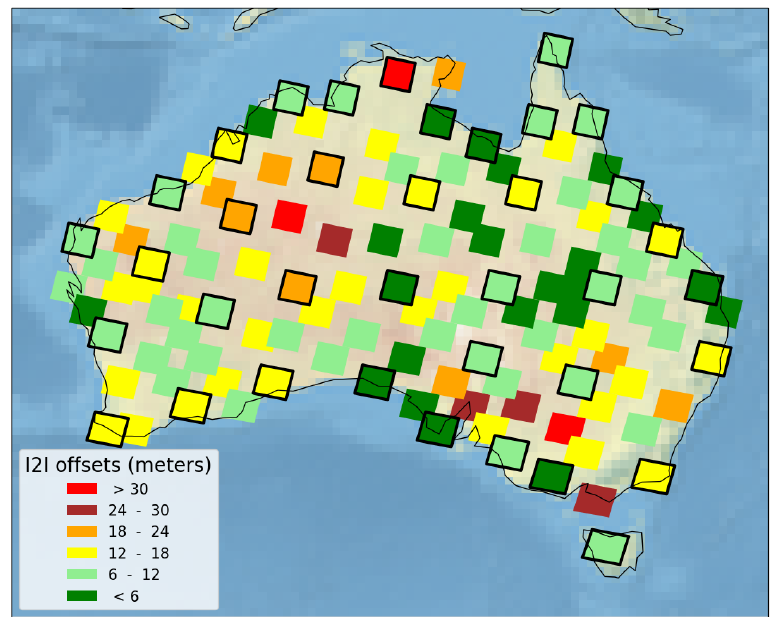
Figure 5. Residual offsets between Landsat-8 orthorectified products using GLS GCPs prior to the triangulation and the AGRI reference data using the image-to-image (I2I) characterization procedure. The anchor sites are indicated by black outline. Note that there are a few sites where the offsets are larger than 30 m with respect to the AGRI, most of which are consistent with the geodetic offsets from Figure